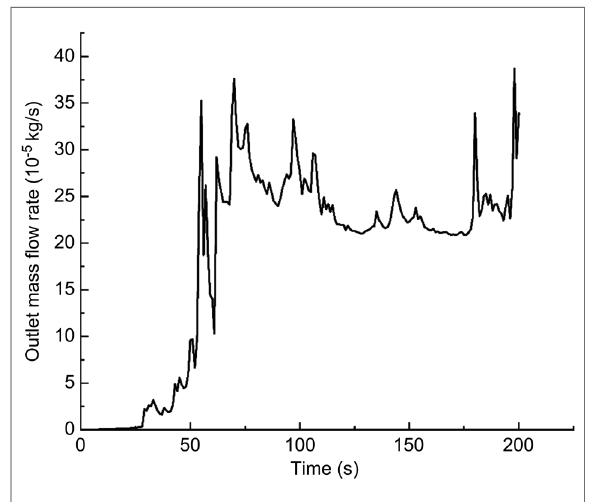
FIGURE 15 The outlet mass fl ow rate monitoring graph of the curved model of the curved plus extended groove